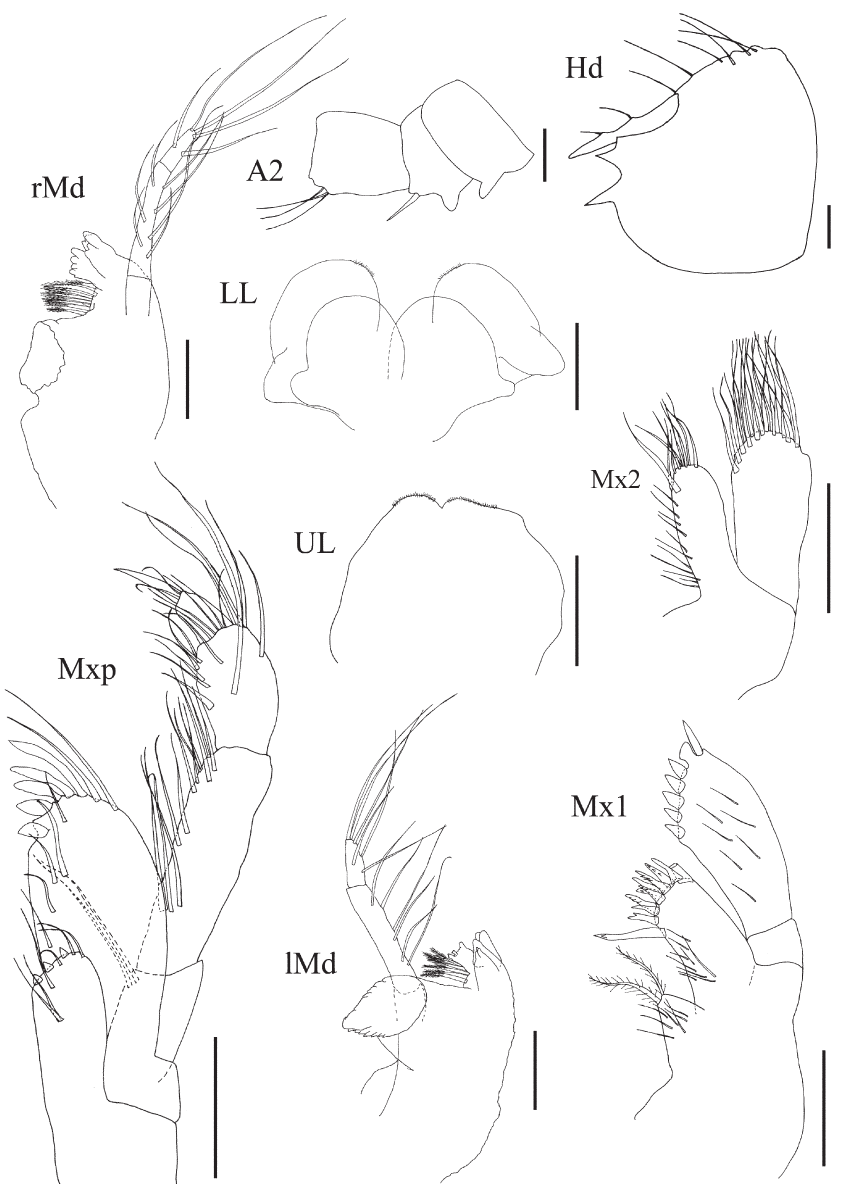
Fig . 5. – Lepechinella hirsuta n. sp., holotype, female, 5.5 mm, MnrJ20523, oceanprof i #60, 21°52’50.5’’S to 39°51’42.6’’w. Scale bars: = 0.1